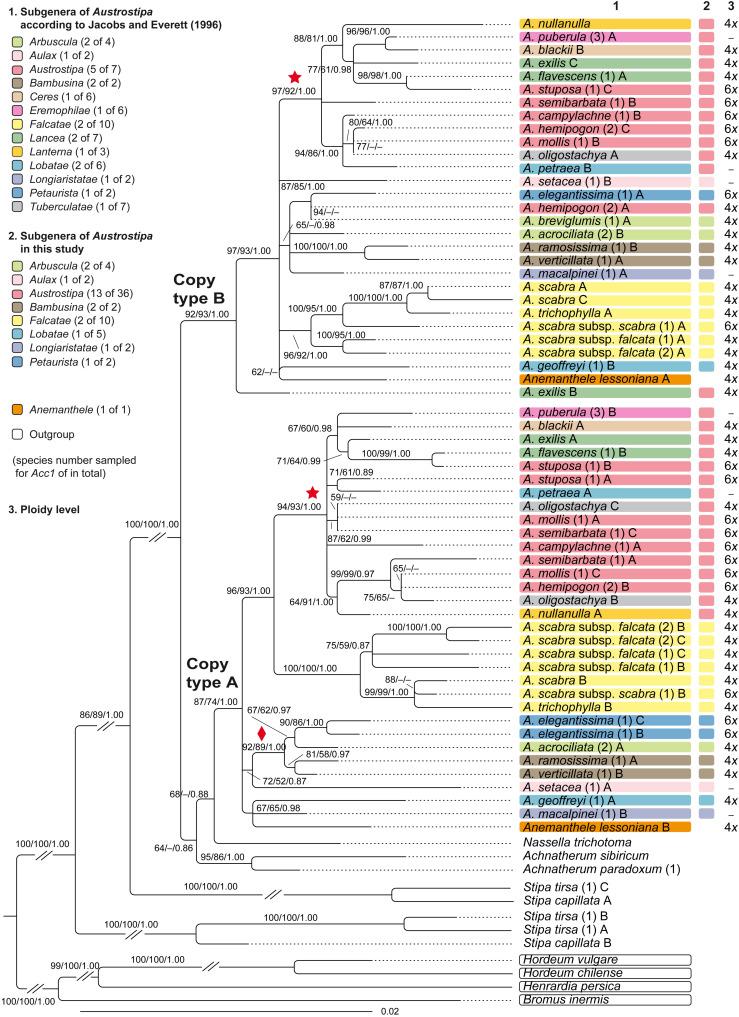
Maximum likelihood phylogram of Austrostipa species, Anemanthele lessoniana and exemplary other taxa of tribe Stipeae (Achnatherum spp., Nassella trichotoma, Stipa spp.) inferred from DNA sequences of the nuclear single-copy locus Acc1 (exon 6–13) with Bromus inermis (Bromeae), Henrardia persica and Hordeum spp. (both Triticeae) used as outgroup. ML and MP bootstrap support values ≥ 50% as well as Bayesian PP ≥ 0.5 are indicated on the branches. Clades with ML support < 50% are collapsed. The asterisked clade within the copy type A and B clades was recovered also in the ITS tree of Figure 2 as well as the clade with diamond. The taxonomic groupings of the Austrostipa species according to Jacobs and Everett (1996) and this study are marked by different colors in columns 1 and 2. The ploidy levels of Austrostipa taxa and Anemanthele lessoniana is given in column 3 according to Winterfeld et al. (2015) and Supplementary Appendix 2. Numbers in brackets after taxon names refer to individual accessions, and different Acc1 sequence copies are labeled by uppercase letters as listed in the Supplementary Appendix 1. A., Austrostipa.